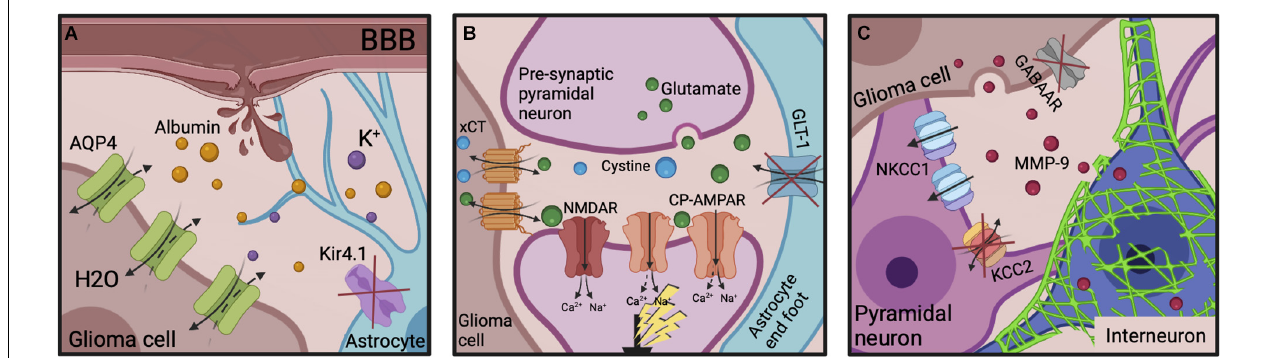
FIGURE 4 | Epileptogenic molecular mechanisms post-GBM resection. (A) The neuroinflammatory environment and BBB disruption originally potentiated by the tumor can also be transiently exacerbated by the resective surgery itself. Serum albumin infiltration evokes Kir4.1 downregulation on reactive astrocytes, enabling K + accumulation. AQP4 expression is increased on glioma cells, decreasing the ECS. (B) Increased xCT expression on glioma cells and decreased GLT-1 expression on astrocytes leads to extracellular glutamate accumulation in the peri-cavity region. It’s post-synaptic action at NMDARs and CP-AMPARs increases neuronal excitability. (C) The remaining glioma cells continue to release MMP-9 which induces PNN degradation. GABA A R expression is almost absent on glioma cells to aid their proliferation. NKCC1 is upregulated and KCC2 downregulated on surrounding pyramidal neurons, reversing the Cl − gradient. The subsequent decreased inhibitory influence disinhibits pyramidal neuronal firing enabling seizure generation. ECS, extracellular space; BBB, blood-brain barrier; NMDAR, NMDA receptor; CP-AMPARs, Ca 2+ -permeable AMPARs; MMPs, matrix metalloproteinases; PNNs, perineuronal nets.